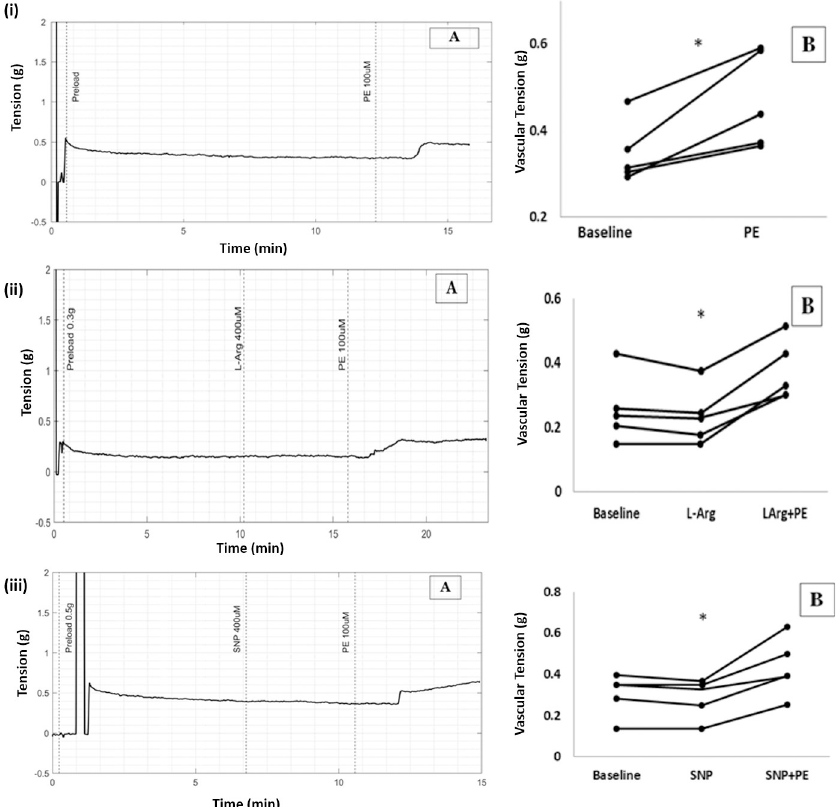
Fig 2. (A) Raw tracings showing changes in vascular tension in circular strips of aorta (B) Scatter plots of results from all five experiments demonstrating increase in vascular tension with PE. (C) Quantum of change with PE from baseline ( � p < 0.05). (i) PE 100uM (ii) PE 100uM in high NO environment caused by L-Arginine (iii) PE 100uM in presence of